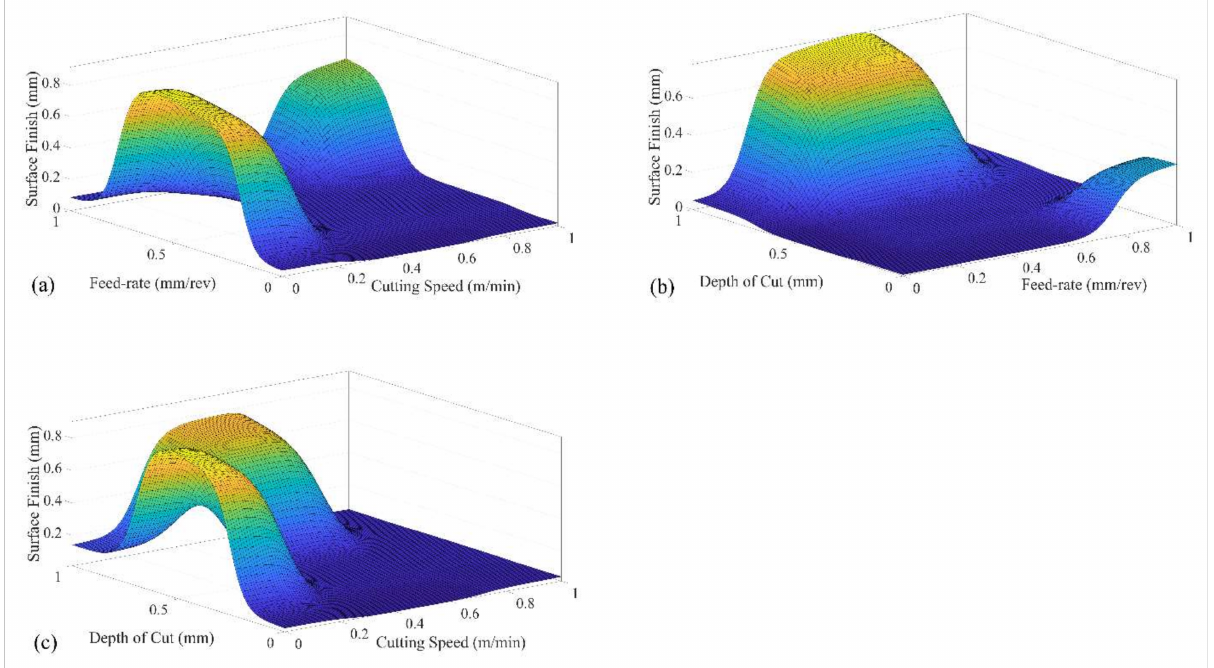
Figure 8. The ruled surface of ANFIS-1 (ANFIS-SR) in terms of cutting parameters ( a ) SR at feed-rate and cutting speed; ( b ) SR at depth of cut and feed-rate; ( c ) SR at depth of cut and cutting